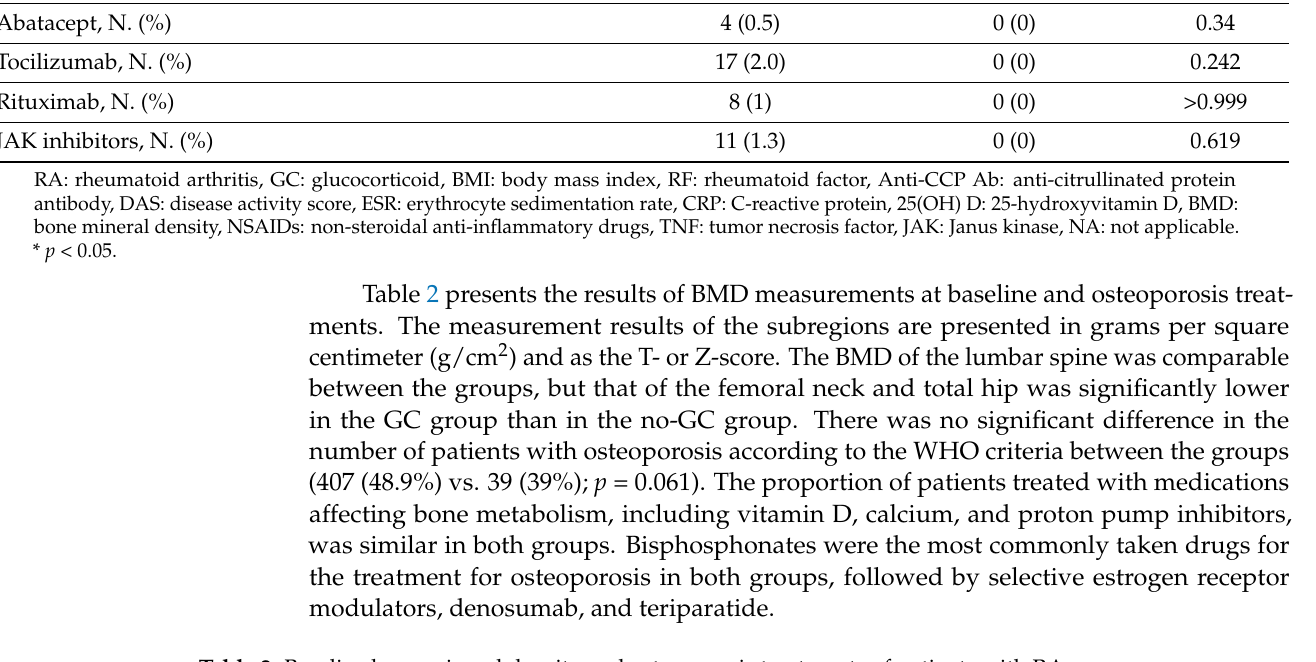
Table 2. Baseline bone mineral density and osteoporosis treatments of patients with